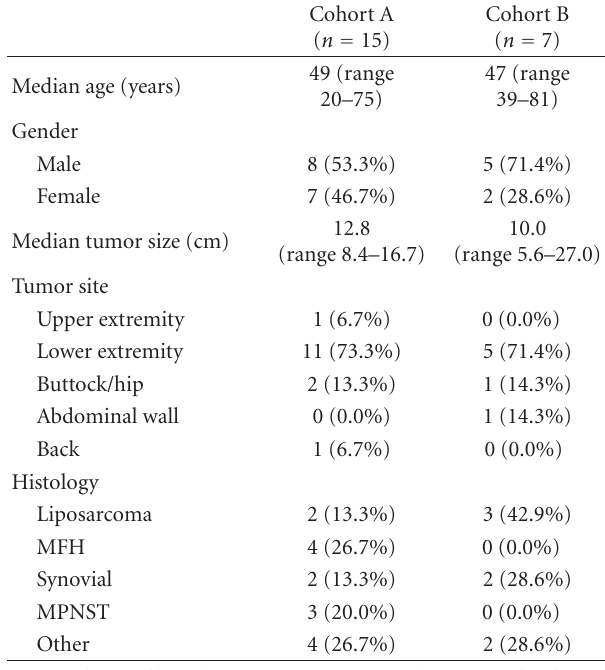
Table 1: Patient and tumor characteristics for cohort A and B patients in RTOG